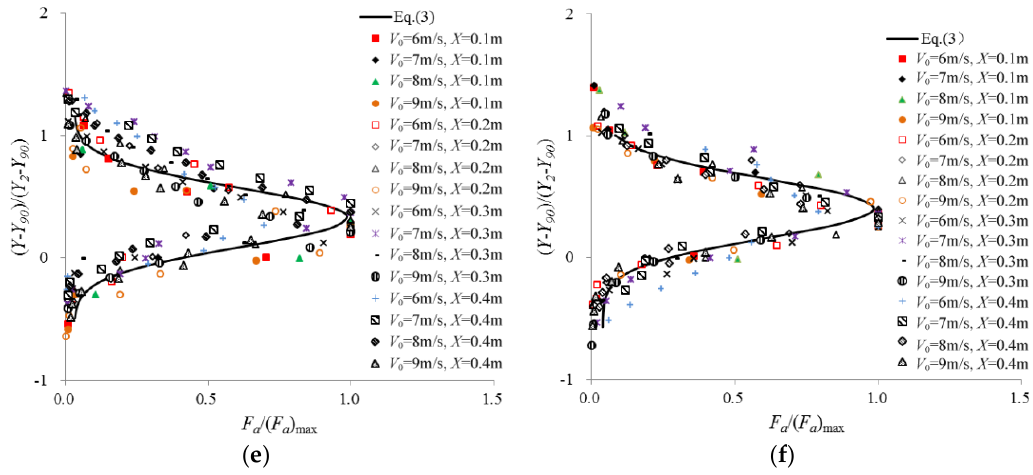
Figure 5. Air bubble frequency distributions compared with the theoretical distribution obtained from Equation (3). Upper nappe ( a ) ( h , b ) = (4.5 cm, 4.5 cm), θ = 25%. ( b ) ( h , b ) = (6.5 cm, 6.5 cm), θ = 10%; lower nappe ( c ) ( h , b ) = (4.5 cm, 4.5 cm), θ = 25%. ( d ) ( h , b ) = (6.5 cm, 6.5 cm), θ = 10%; side nappe ( e ) ( h , b ) = (4.5 cm, 4.5 cm), θ = 25%. ( f ) ( h , b ) = (6.5 cm, 6.5 cm), θ = 10%.